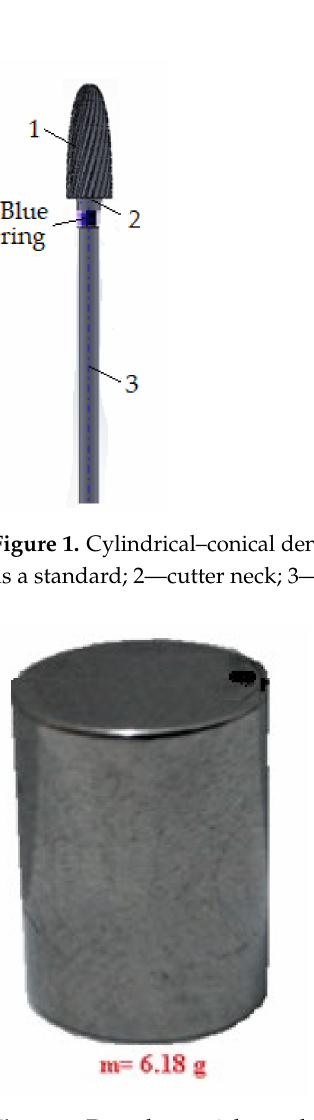
Figure 2. Dental material sample (Ni-Cr